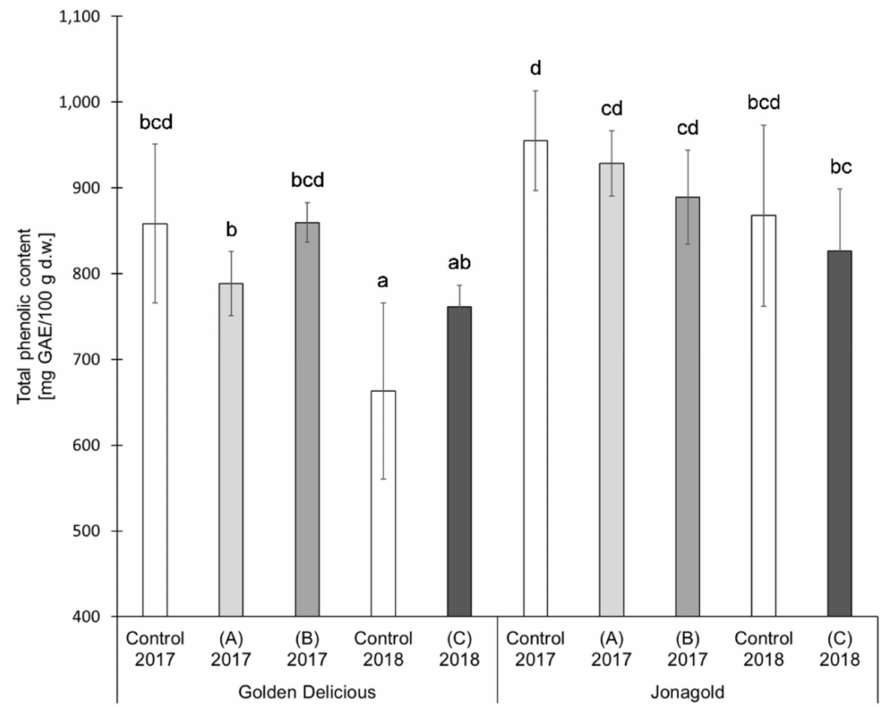
Figure 3. Total phenolic content (TPC) in mg GAE / 100 g d.w. for the apple samples, depending on harvest year, apple variety, and form of selenium. Foliar Se application per hectare and meter canopy height: 0.15 kg as selenite (A), or selenate (B), 0.075 kg as selenate (C) ( n = 4). Di ff erent letters are significantly di ff erent ( p <